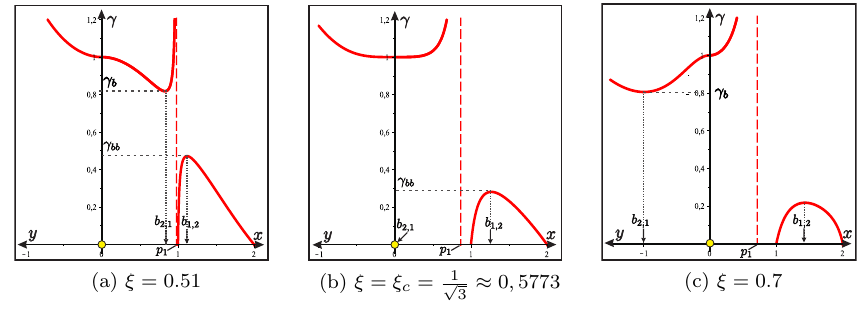
Figure 4. Real CF at RP q =